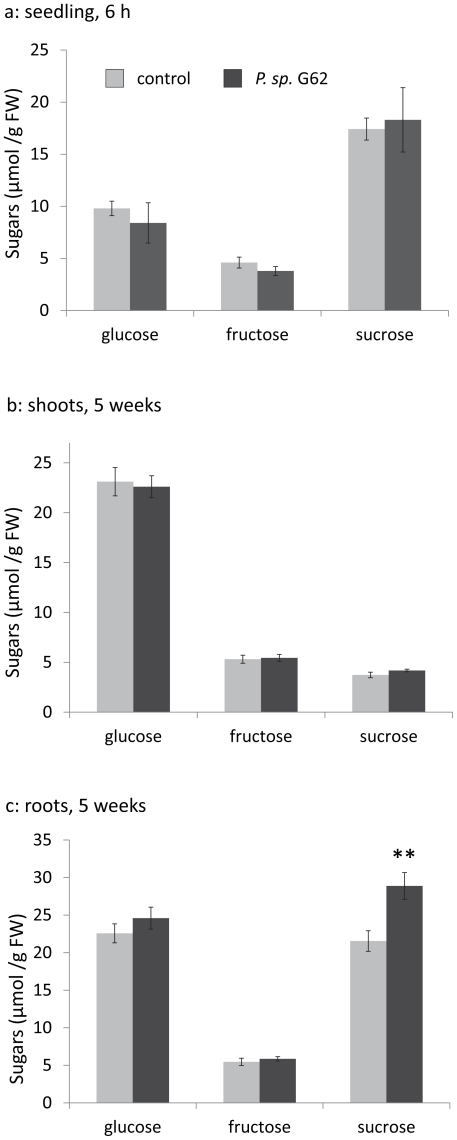
Levels of sucrose, glucose and fructose in different tissues after bacteria treatment.a: sugars in seedlings treated with bacteria for 6 h; sugars in shoots (b) and roots (c) of 5-week-old Arabidopsis Col-0 plants after seed inoculation with P. sp. G62. Mean values ± SE, asterisks indicate p-values (**: p<0.01).